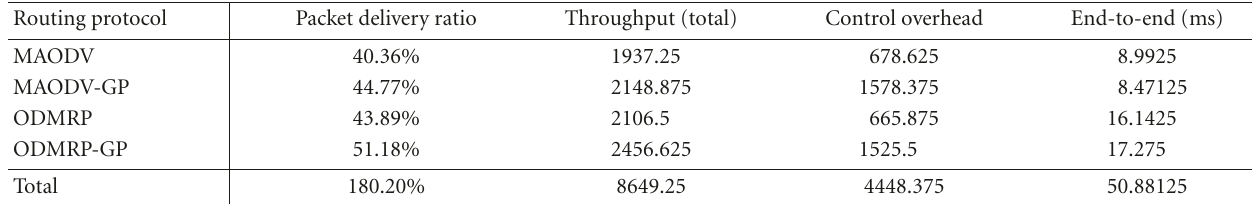
Table 4: Average performances for multicast (30 nodes).